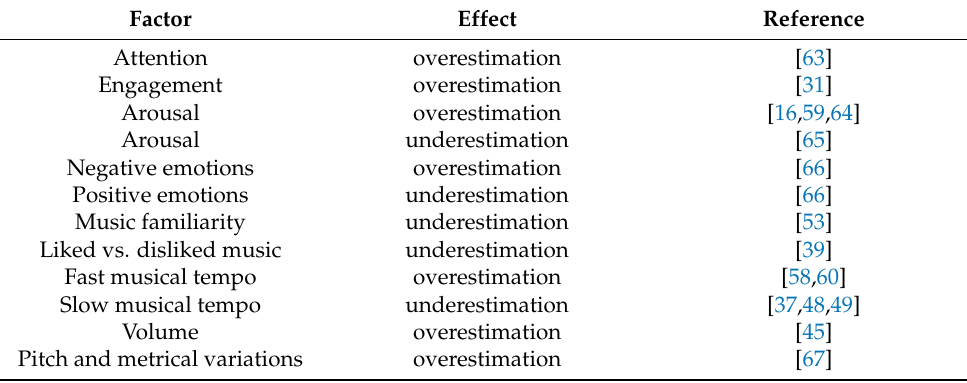
Table 1. Factors influencing time